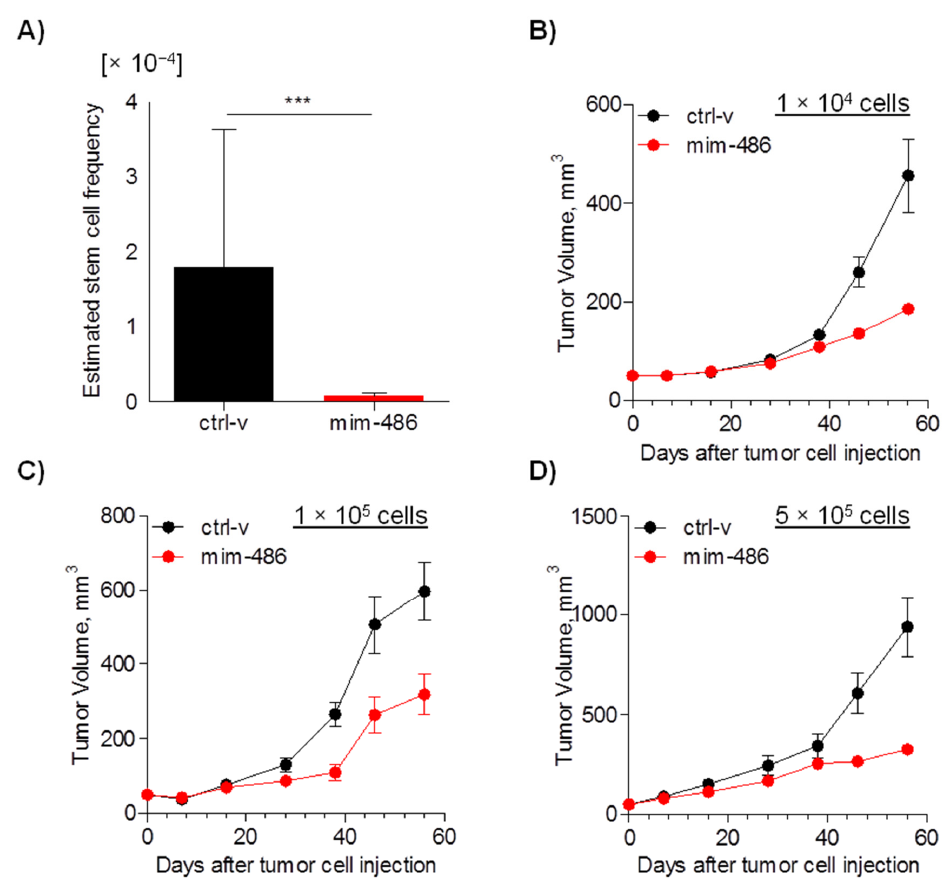
Figure 4. miR-486-5p reduces cancer stem cell frequency in vivo. ( A ) Estimated cancer stem cell frequency evaluated by Extreme Limiting Dilution Assay (ELDA) in A549 cells transfected with mim-486 or control vector. ( B – D ) Growth curves of A549 cells injected subcutaneously in SCID mice at 1 × 10 4 , 1 × 10 5 , and 5 × 10 5 cells. ELDA data are expressed as median and interval between minimum and maximum; in vivo growth data are expressed as mean ± standard error of the mean (SEM).